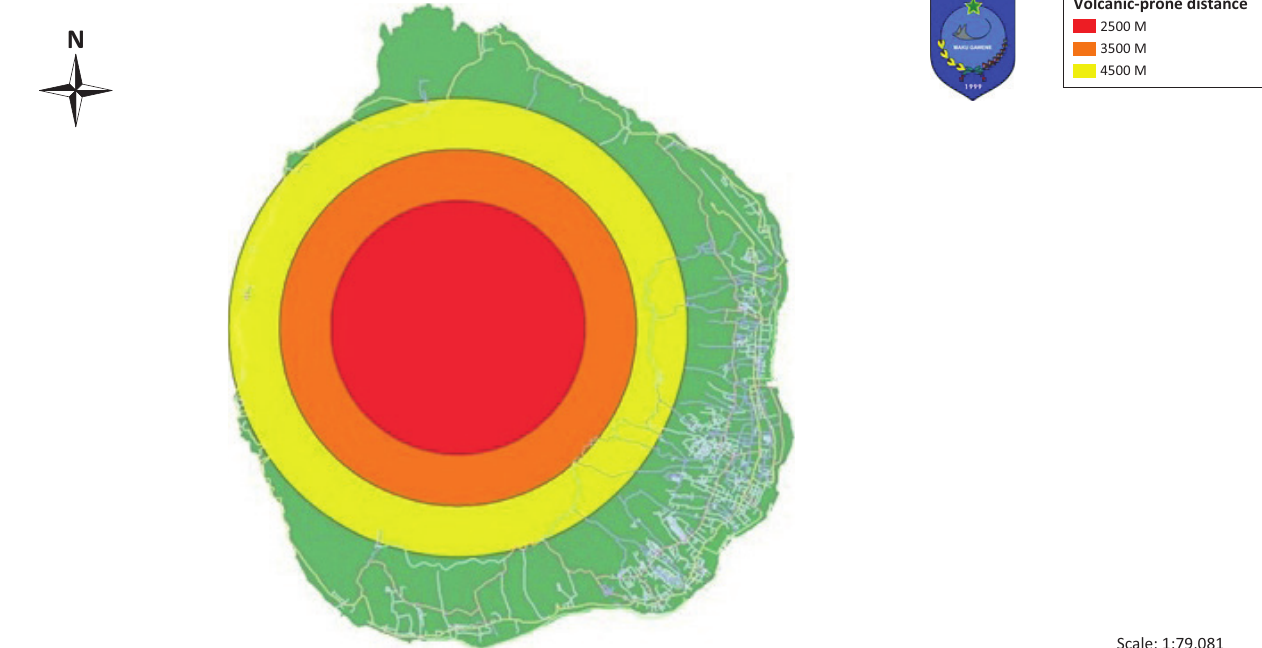
FIGURE 3 : Gamalama mountain prone zone.